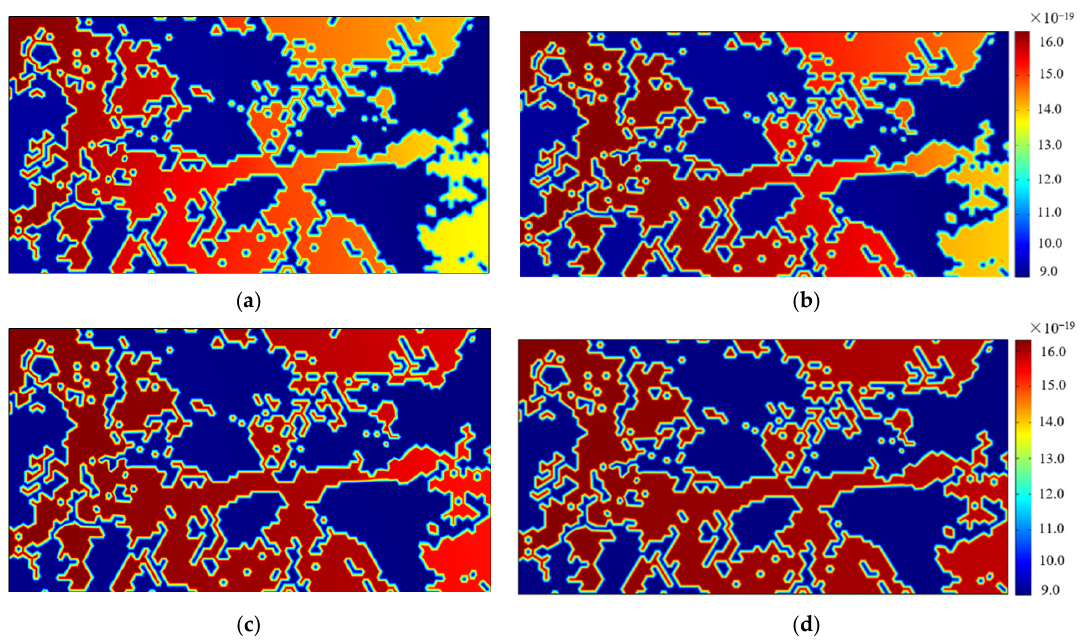
Figure 9. Permeability variation characteristics at different times. ( a ) 0.2 min; ( b ) 2 min; ( c ) 5 min; ( d ) 10 min.